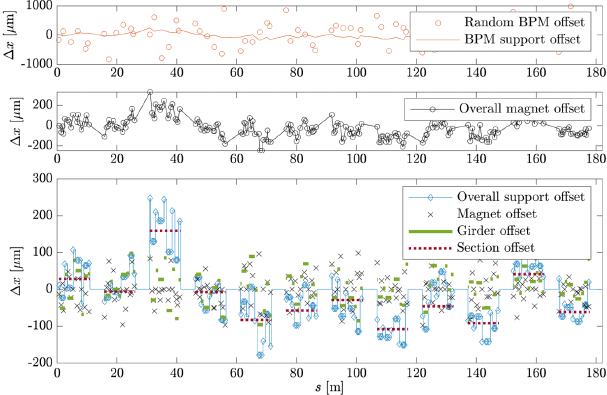
FIG. 6. An example of the horizontal offset distribution for the ALS-U accumulator ring.